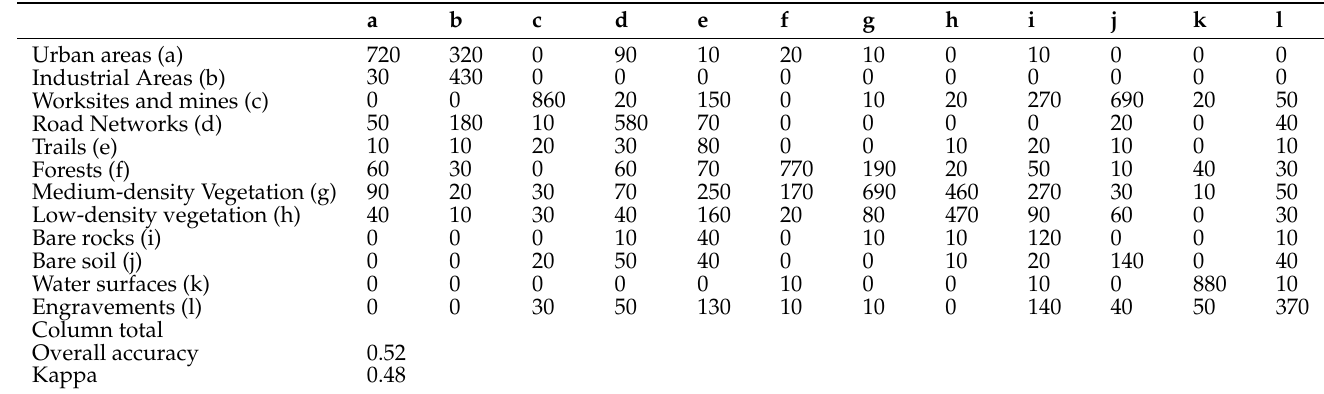
Table 7. Error matrix for accuracy assessment of LULC classification based on deep learning (Rousset et al. [47]).